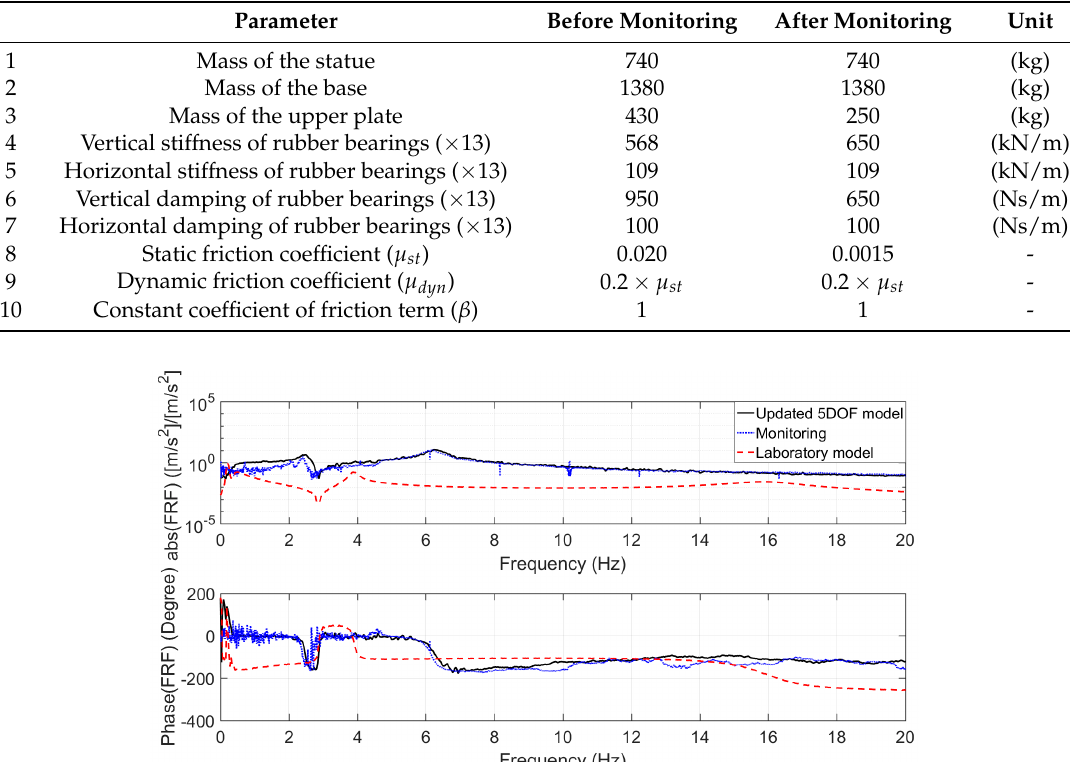
Table 2. The updated parameters of the 5DOF model according to the FRF of the isolation system in the museum.